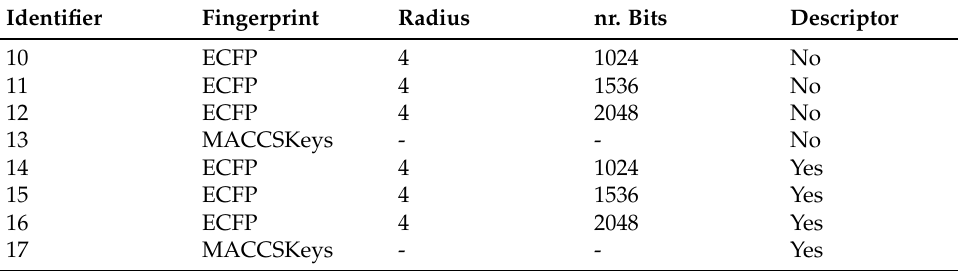
Table A7. Non-GNN featurization. The identifier is used as